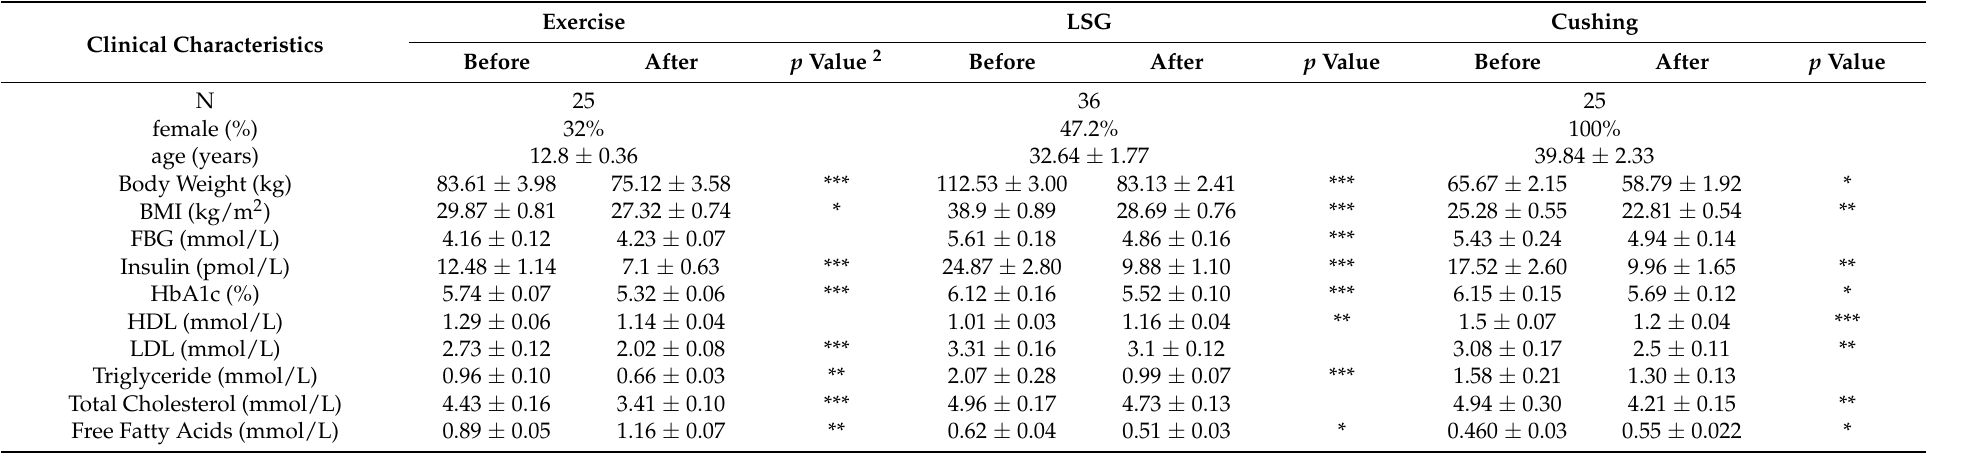
Table 1. Baseline characteristics of the study populations 1